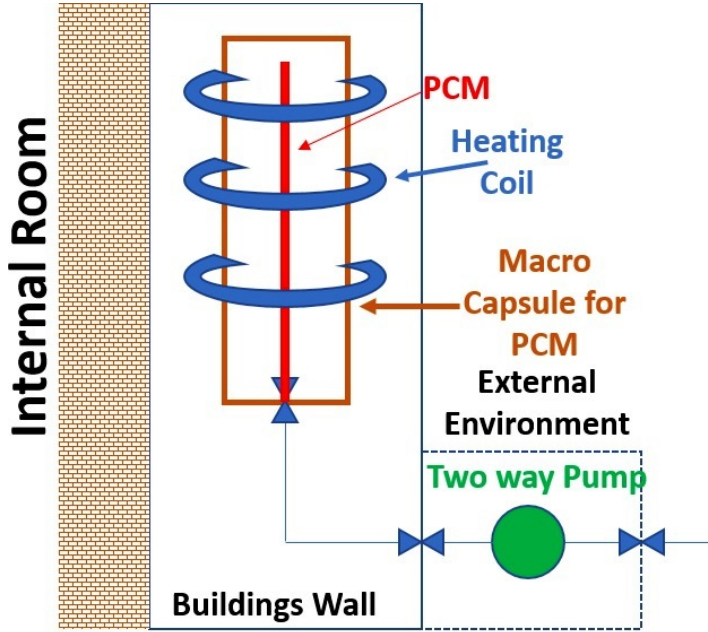
Figure 5. Schematic Drawing of PCM Pump System.